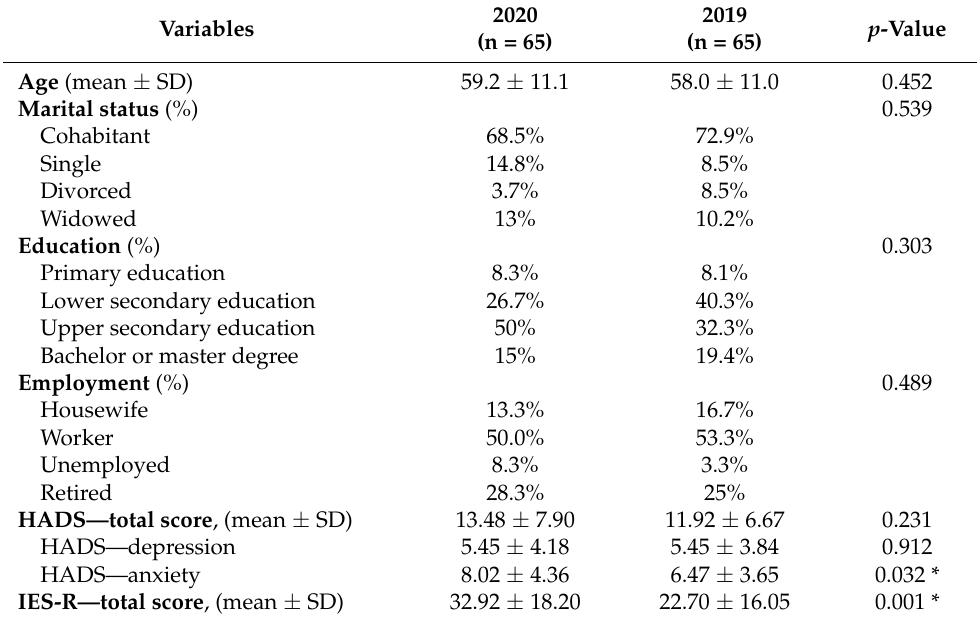
Table 1. Socio-demographic and psychological variables in 2020 patients’ group, compared to the 2019 group.